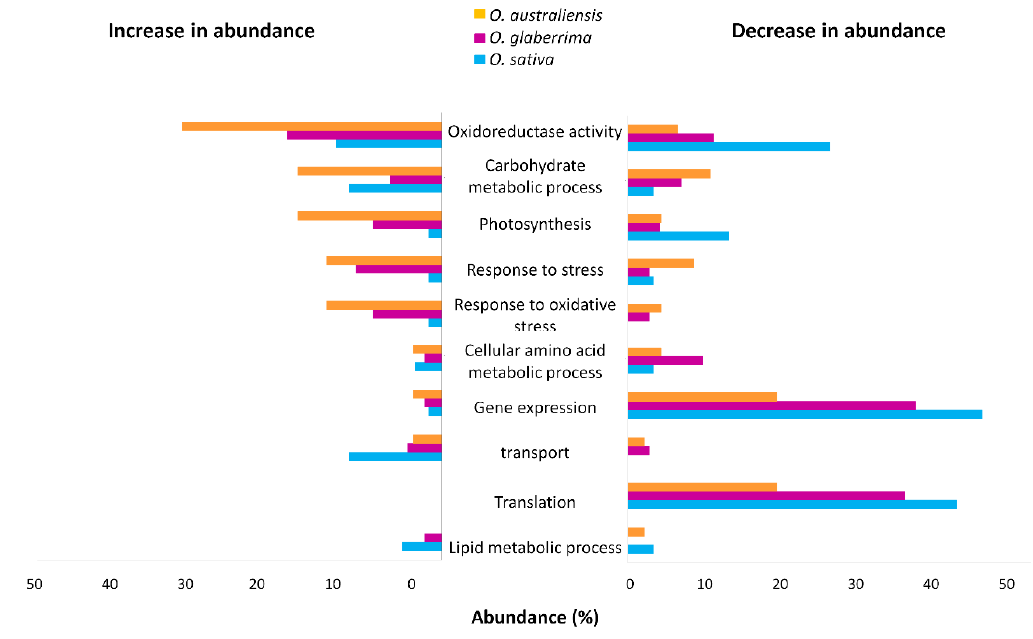
Figure 5. Functional classification of differentially accumulated proteins under drought stress conditions. The bars illustrate the percentage of proteins in 10 functional categories that are significantly changed under drought stress. Different colors represent different species of rice, as indicated.